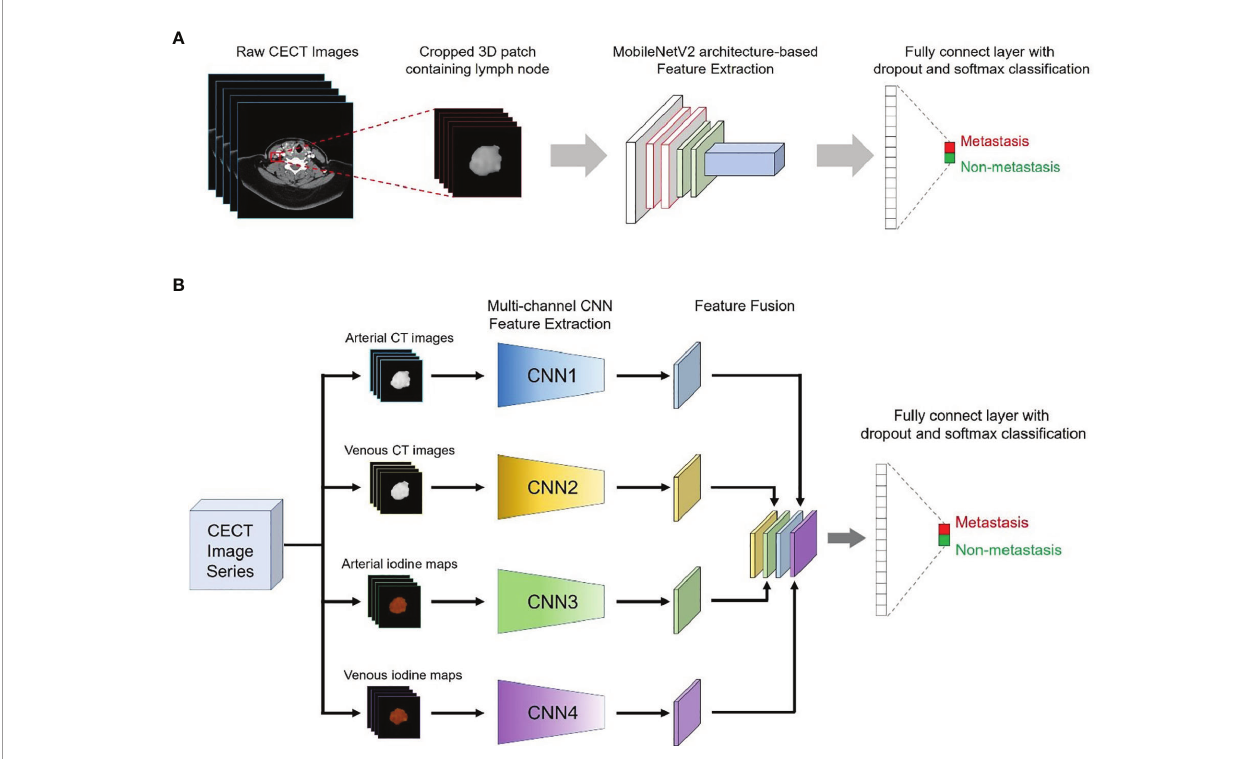
FIGURE 2 | Conceptual architecture of the single-modality DL model (A) and the multichannel DL model integrating all ROIs from the CT images and iodine maps (B)